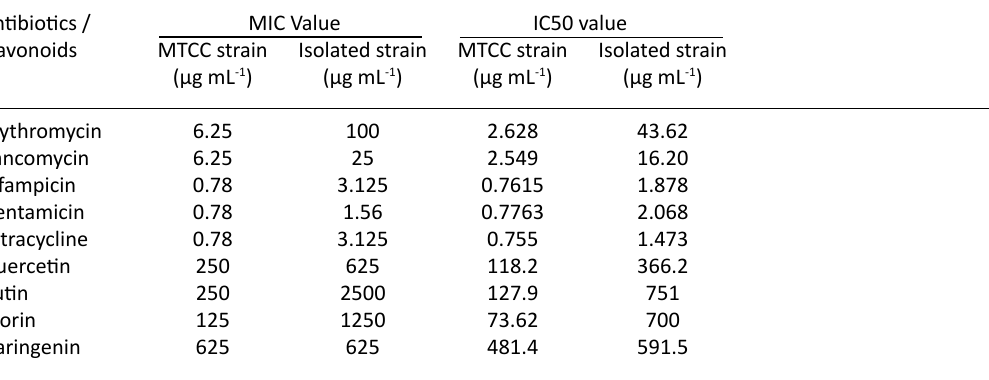
Table 1. IC50 value (Inhibitory Concentration) and Minimum Inhibitory Concentration (MIC) value of antibiotics and flavonoids against Staphylococcus aureus Antibiotics / MIC Value IC50 value Flavonoids MTCC strain Isolated strain MTCC strain